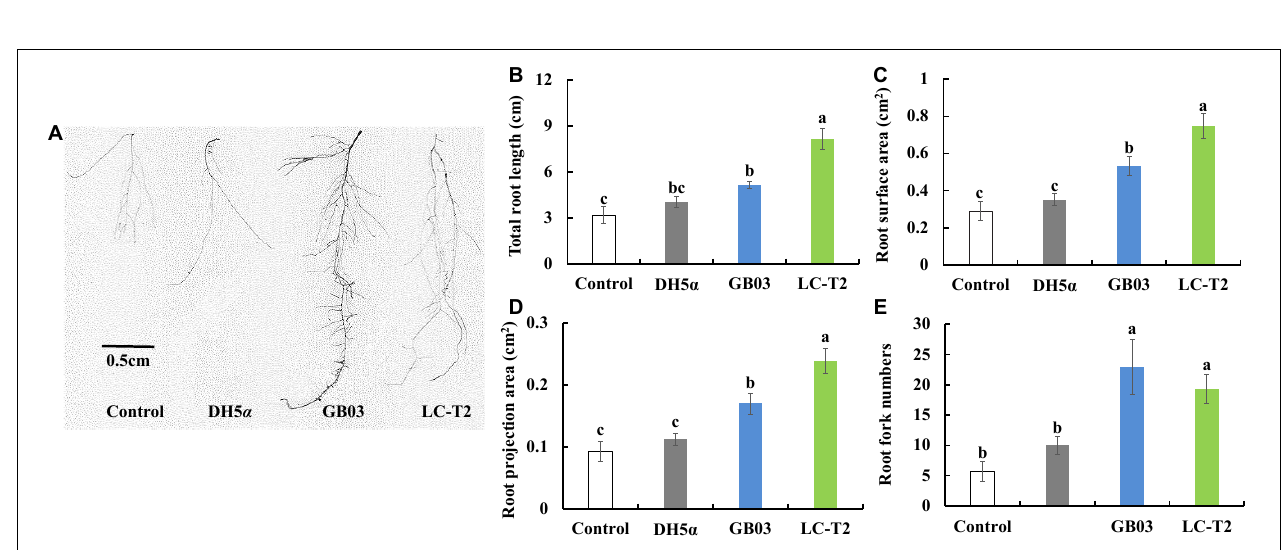
FIGURE 3 | Effects of roots growth of Arabidopsis exposure to LC-T2 T volatile organic compounds (VOCs). Escherichia coli (DH5 α ) and Bacillus amyloliquefaciens (GB03) as positive control l. (A) plant root image, (B) total root length, (C) root surface area, (D) root projection area, and (E) root fork numbers. Seedlings were taken image and root growth index were measured after 2 weeks exposure to E. coli (DH5 α ), B. amyloliquefaciens (GB03), and Paenibacillus monticola LC-T2 T , respectively. Values are means and bars indicate SDs ( n = 6). Columns with different letters indicate significant difference at P < 0.05 (Duncan test).